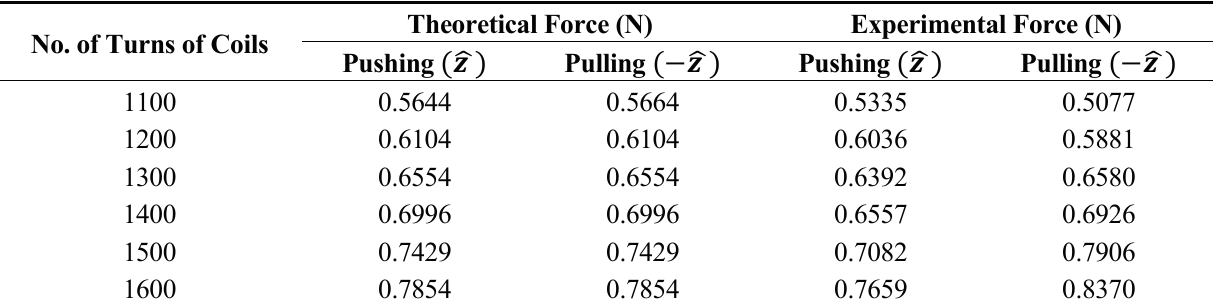
Table 1. The pulling and pushing electromagnetic forces from the solenoid actuator and the comparison of theoretical forces with experimental results for various coil